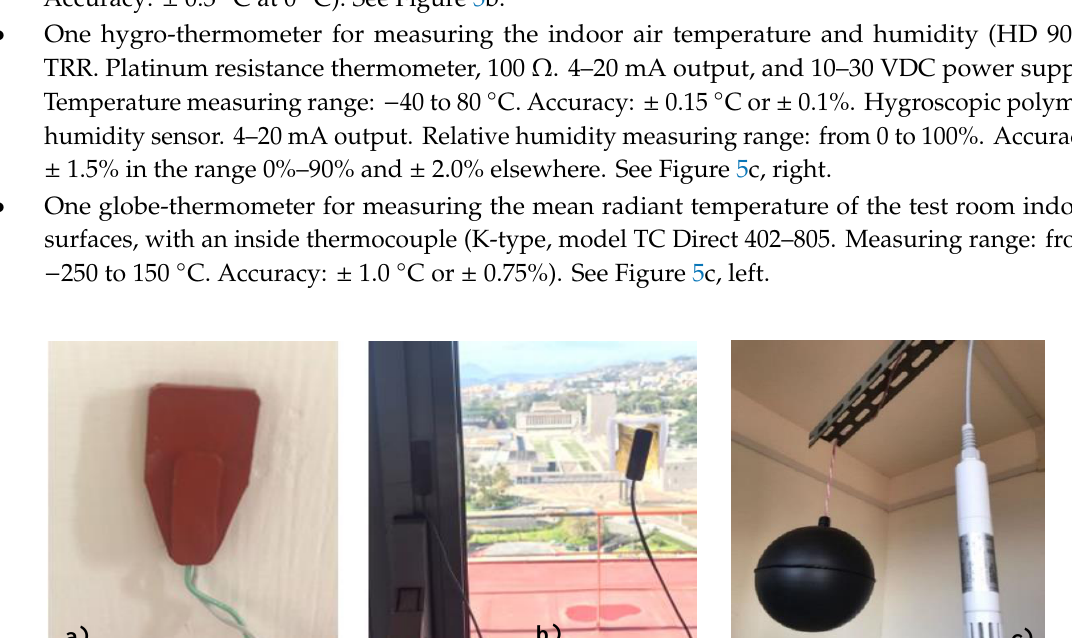
Figure 5. ( a ) Thermocouple K-type; ( b ) thermoresistance; ( c ) globe-thermometer and hygrothermometer. All such devices are here shown without the reflecting shielding elements used during the experimental analysis.